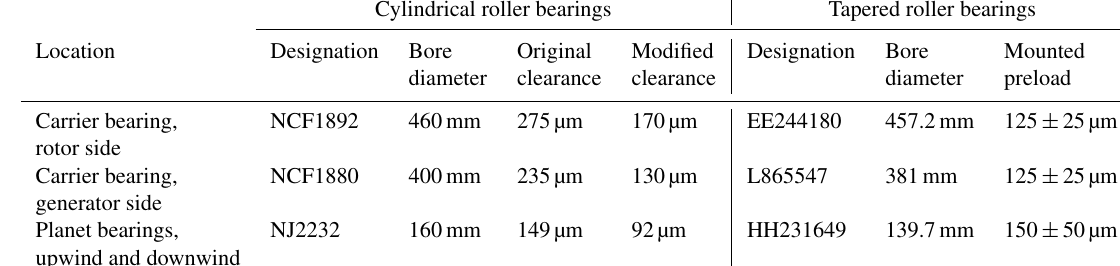
Table 1. Parameters of the planetary bearings.